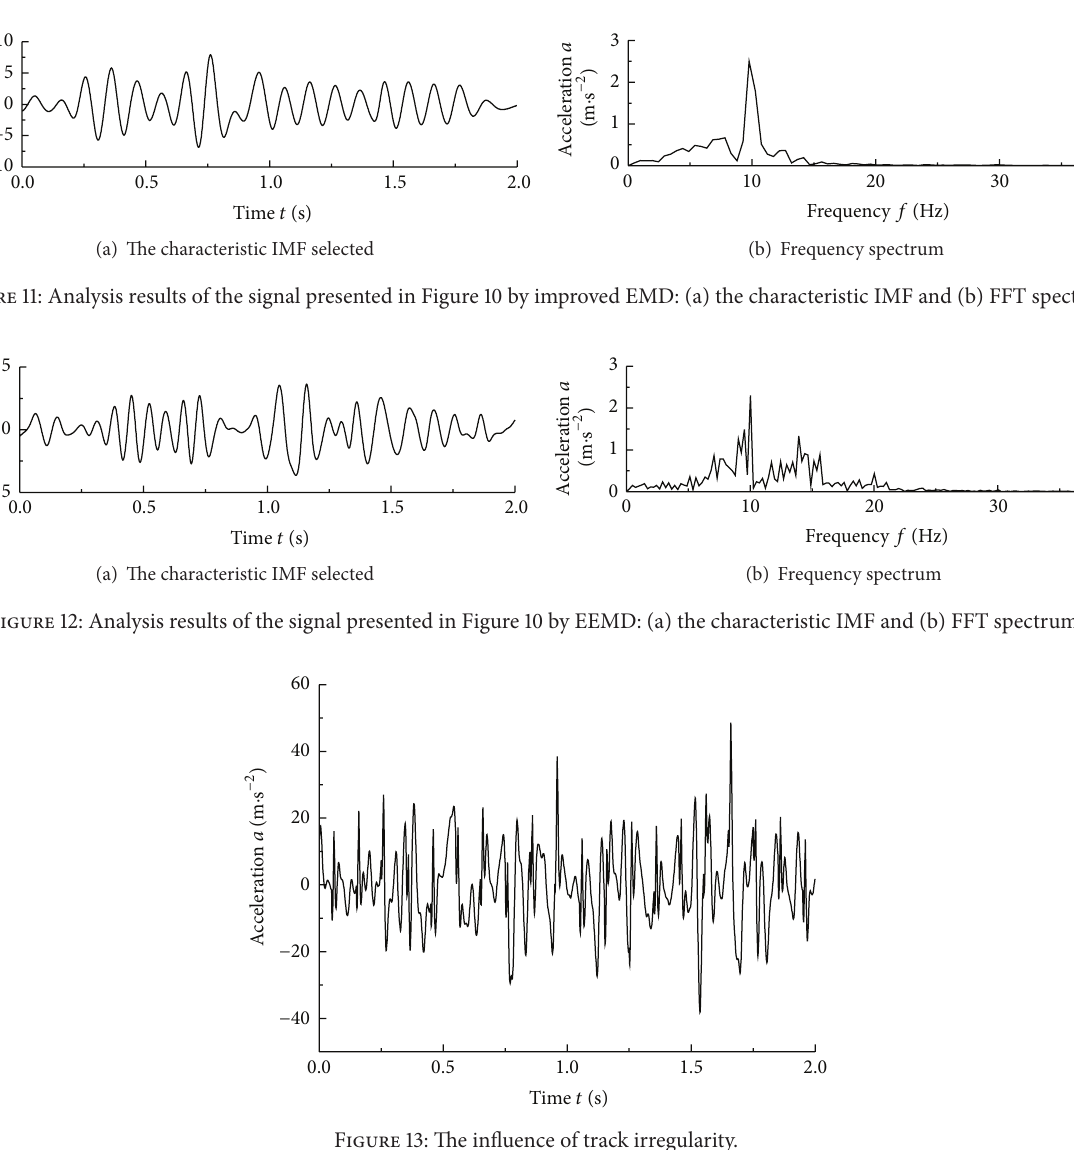
Figure 13: The influence of track